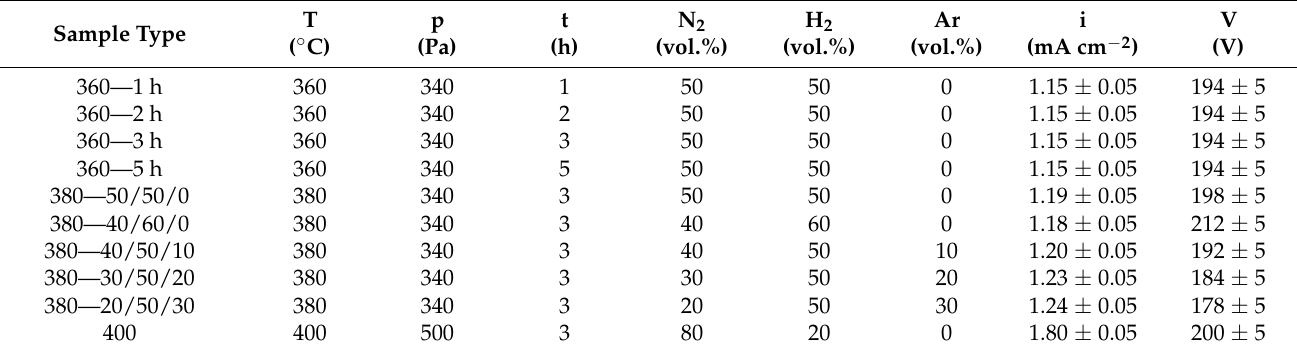
Table 1. Nitriding conditions. i: current density. V: voltage